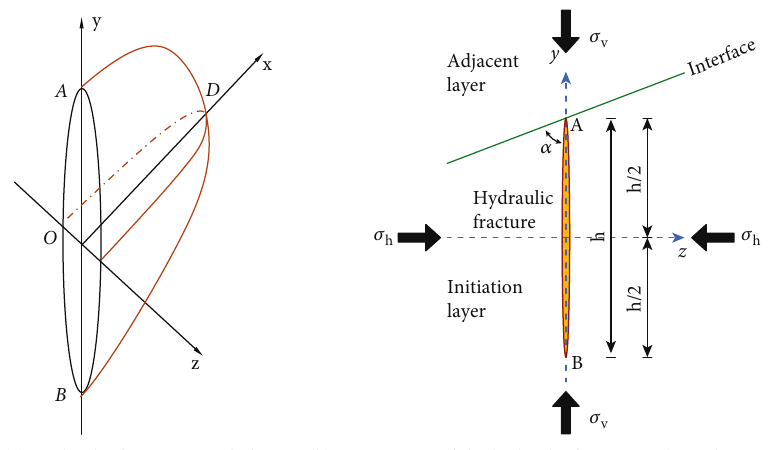
Figure 1: Schematic diagrams of the physical